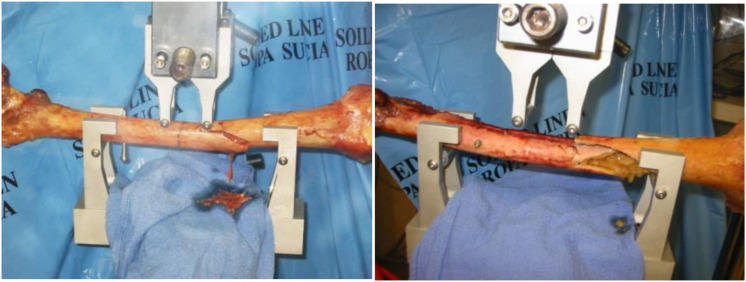
Failure along the shaft due to bending.